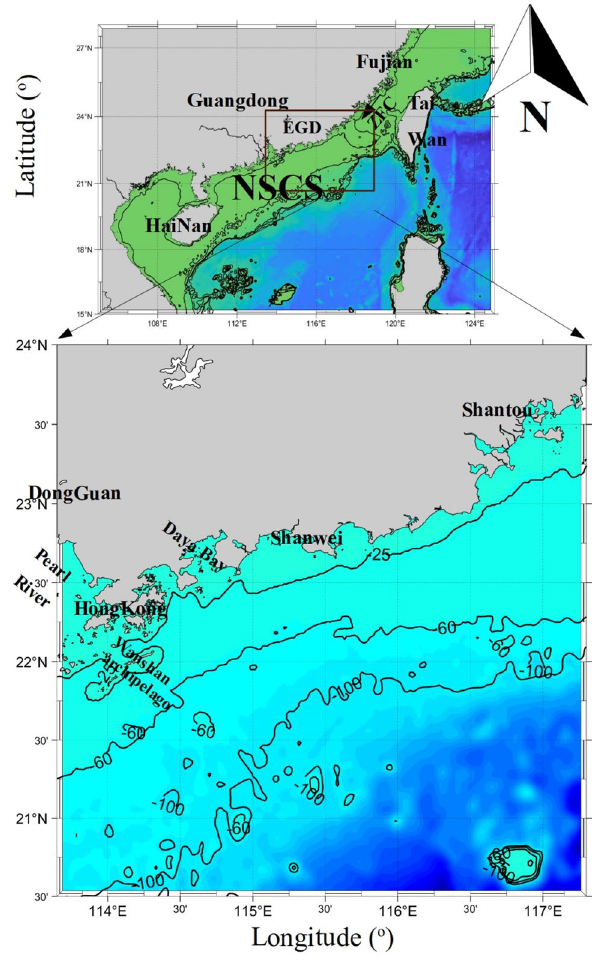
Figure 1. Map of the study area. The program R (version 3.6.3, available at https:// www.r- proje ct. org) was applied for the